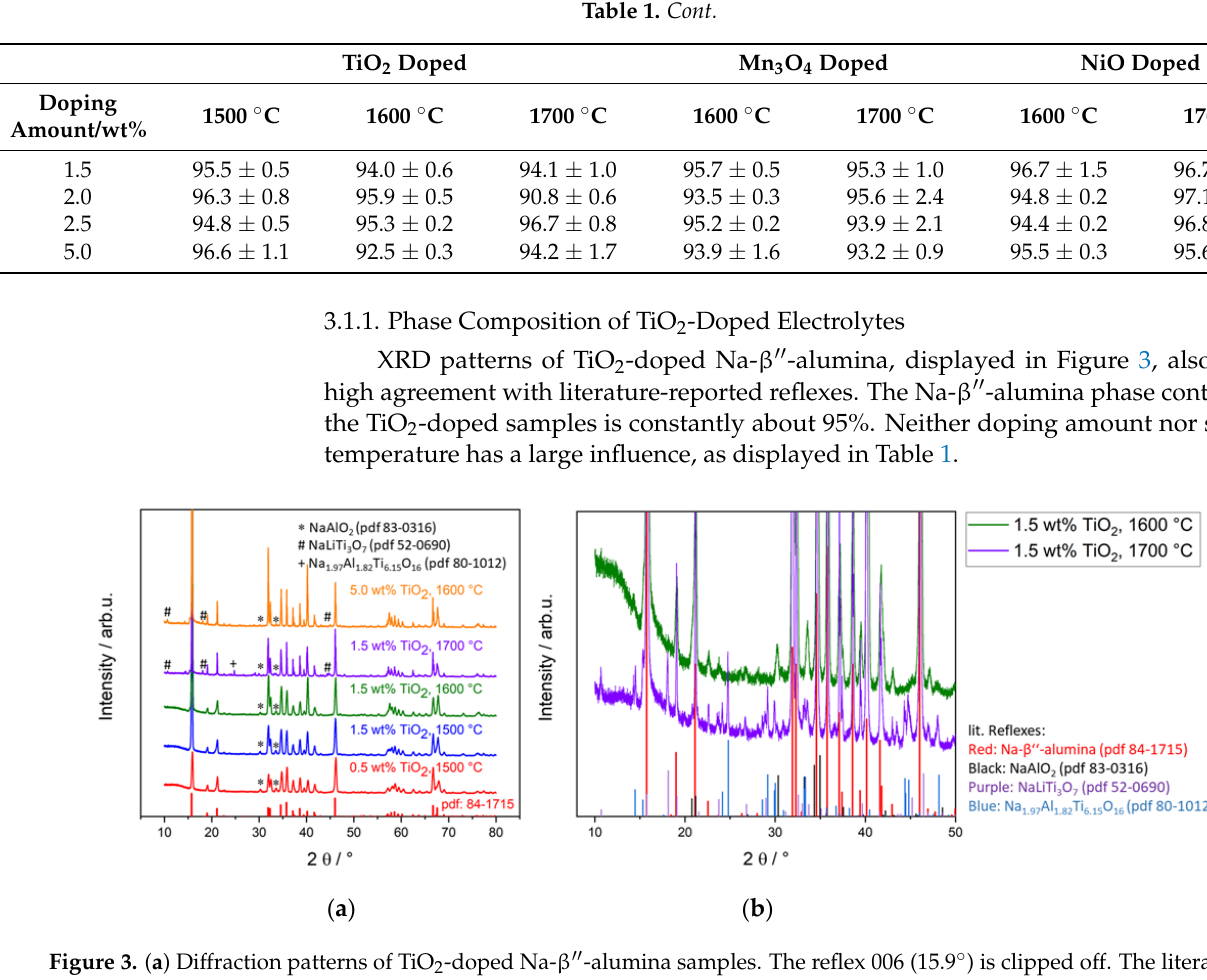
Table 1. Na- β″ -alumina phase content [wt%] of differently sintered and doped samples.